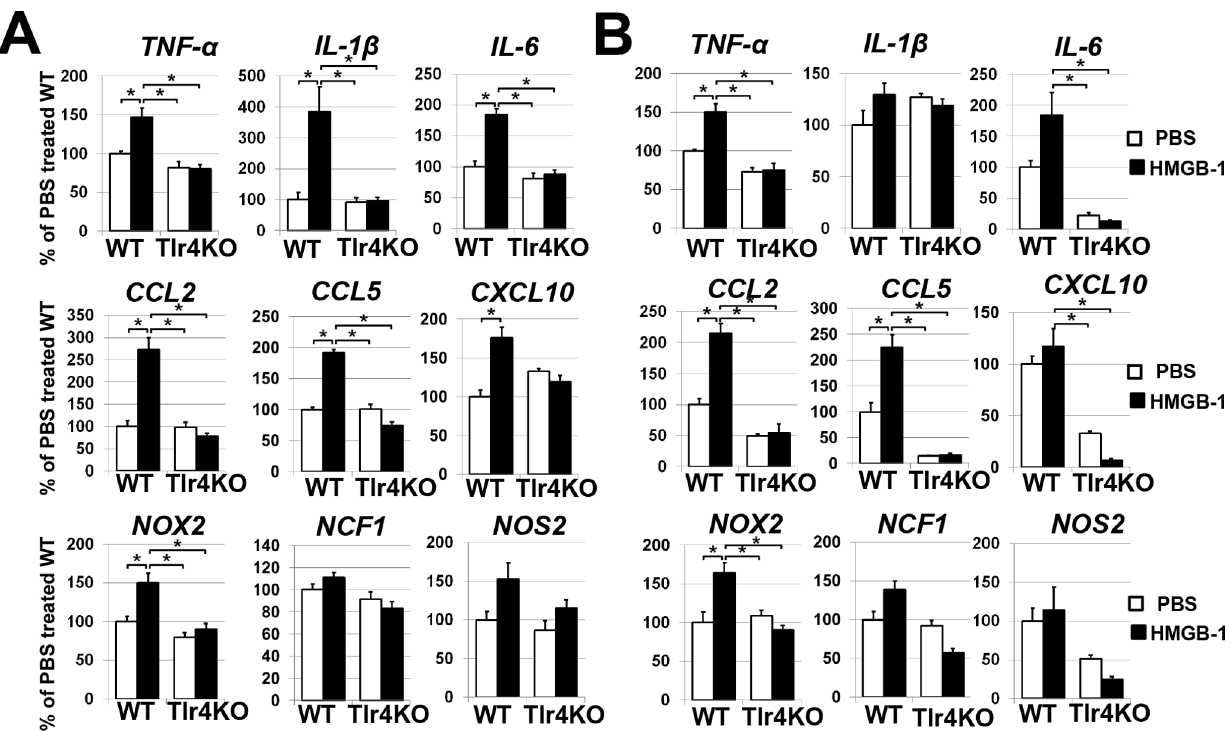
Figure 2. HMGB-1 induces expression of pro-inflammatory markers in astrocytes (A) and microglial cells (B) isolated from wild type (WT) animals. TLR4 deficiency (Tlr4KO) suppresses induction of pro-inflammatory markers after HMGB-1 treatment. Gene expression was assessed using quantitative RT-PCR in PBS treated controls and HMGB-1 treated cells. For each gene, results are expressed as a percentage of the corresponding value in the PBS treated primary glial cell cultures isolated from WT animals after normalization to b -actin (*P , 0.05, n=6).